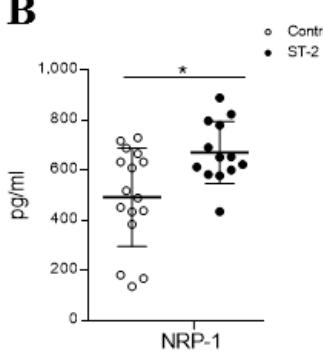
Figure 2. NRP-1 expression in HCFs treated with sST2. sST2 effect on intracellular NRP-1 expression ( A ) and sNRP-1 ( B ) in HCF. All conditions were performed at least in triplicate. Scatter dot plots represent the median and minimum to a maximum range of N = 8-16 replicates per condition. For Western blot experiments, protein densitometry was expressed in arbitrary units (AU) once normalized to stain-free for proteins. Representative blots have been displayed when appropriate. * p < 0.05 vs. control. NRP-1: neuropilin 1 and sNRP-1, soluble/secreted NRP-1 isoform.